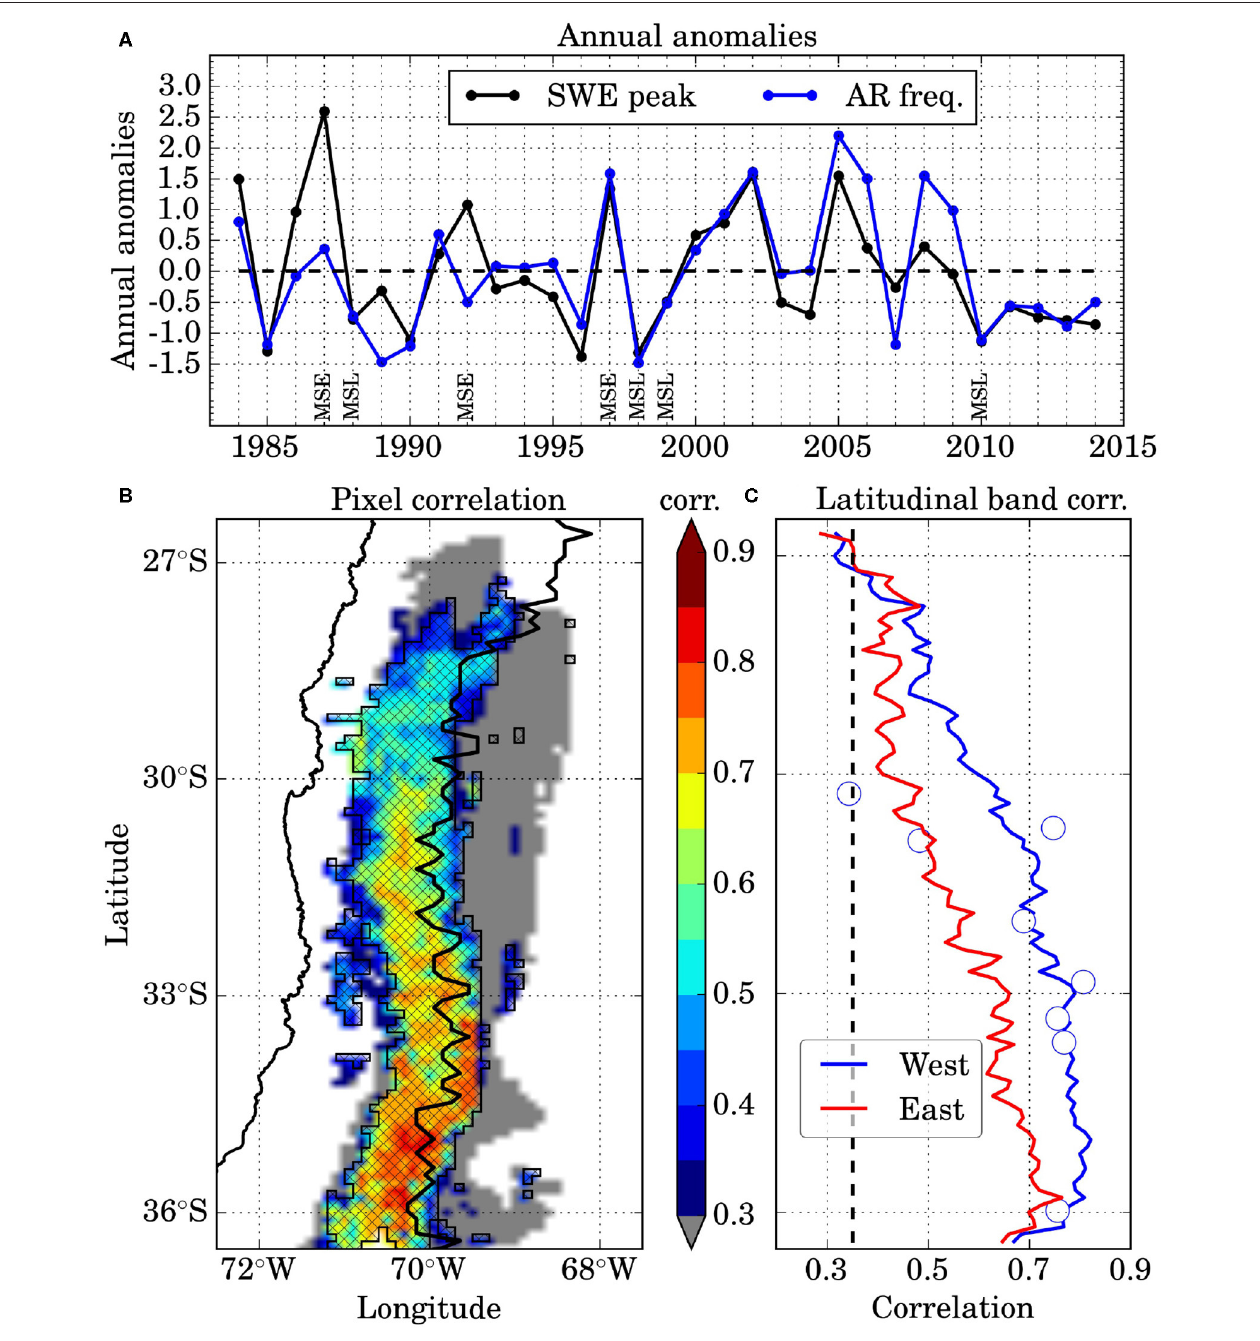
FIGURE 5 | (A) Time series of annual standardized anomalies of the regional SWE peak and AR contribution to snow accumulation. (B) Correlation between annual time series of peak SWE peak and AR frequency on the pixel scale (dashed pixels indicate significant correlation). Thick black line indicates the crest of the Andes. (C) Variation with latitude of correlations between annual time series of SWE peak and AR frequency latitudinally averaged on the western (blue) and eastern (red) slopes. The correlations at some available Snow pillows sites are shown by the circles. Dashed black lines represent the 95% significance level for the correlations.